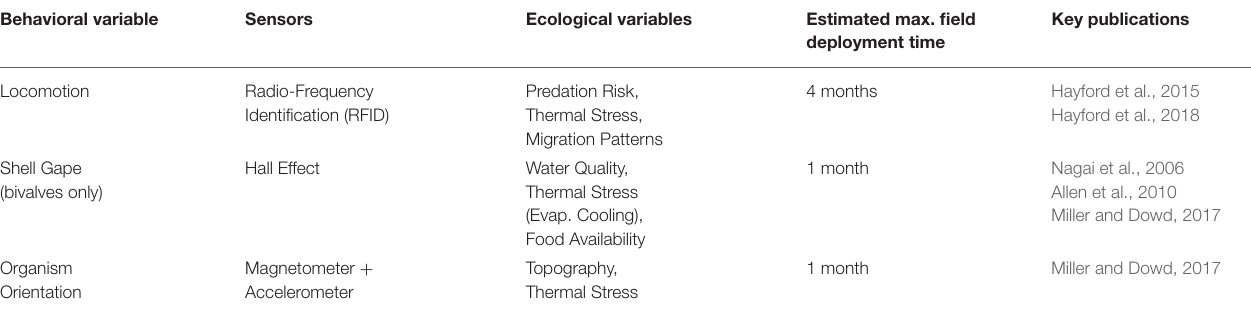
TABLE 3 | Behavioral datalogging methods and technologies for intertidal